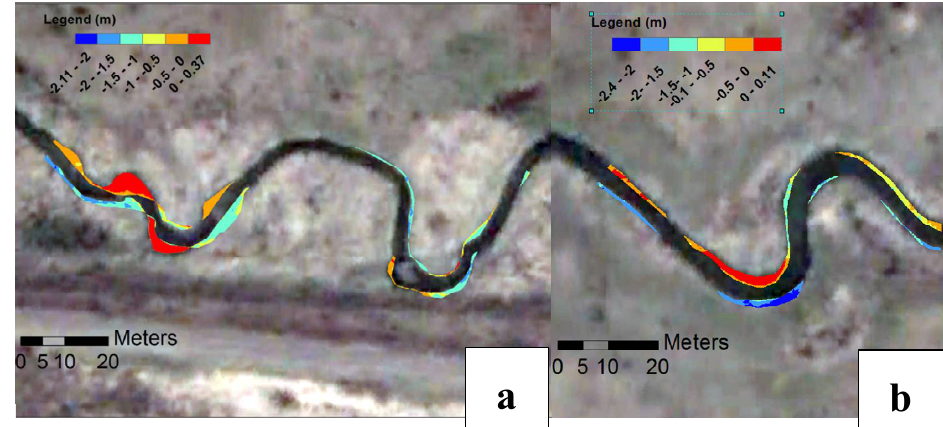
Figure 9. Erosion (negative) and deposition (positive) (m) from 2006 to 2014 in: ( a ) M4 and ( b ) M3 sampling reaches. Background image adopted form google earth image (2004). Table 2. Channel geometry of each sub-reaches of the study creek within different years.